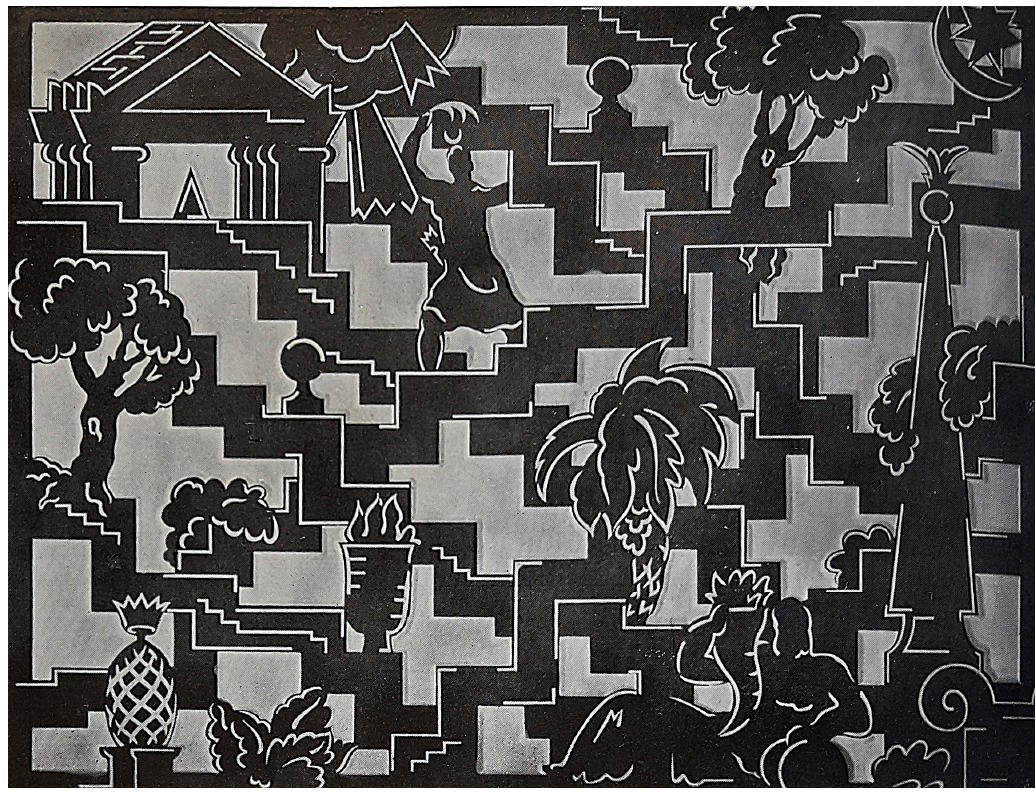
Figura 4. Pietro Chiesa (execution), engraved glass panel, composition by T. Buzzi,